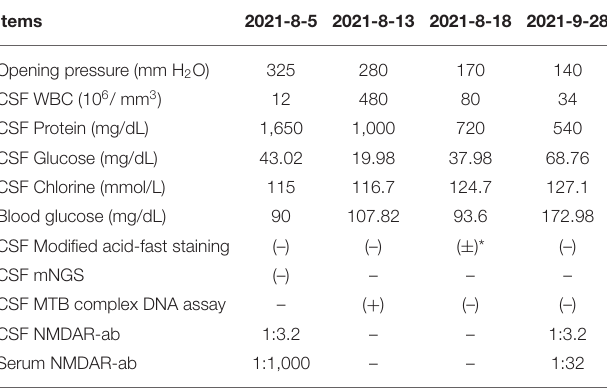
TABLE 1 | Some data of laboratory